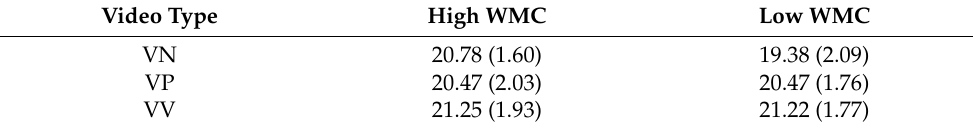
Table 1. Average comprehension scores of the three video types in the high and low WMC